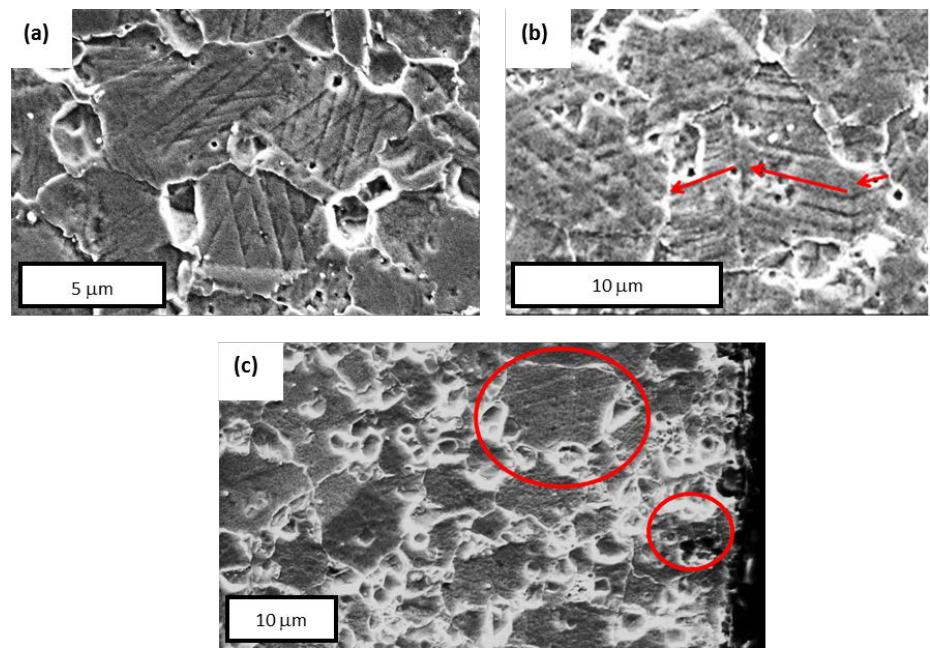
Figure 7. Intra-granular strain deformation in swaged material ( a ) intersecting slip; ( b ) slip defining twinning; ( c ) within isolated grains beneath a shot peened surface.